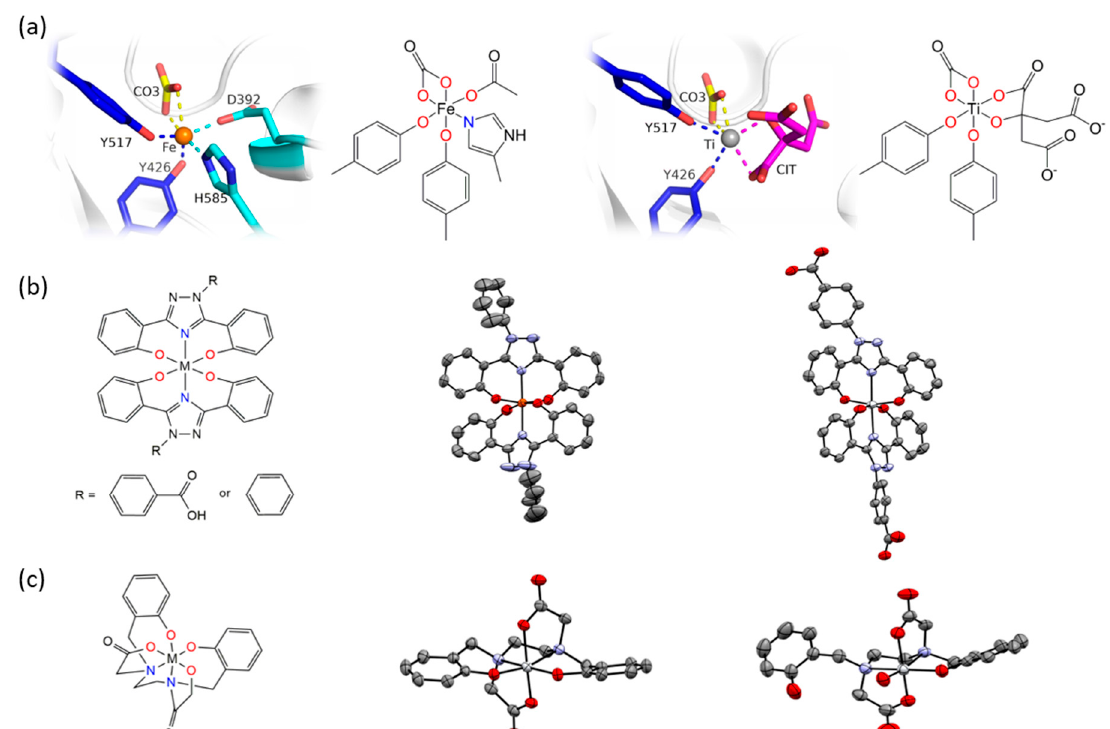
Figure 6. X-ray structures of Fe(III) and Ti(IV) coordination by serum transferrin (sTf) and by the small molecule chemical transferrin mimetic ligands. ( a ) The X-ray structures and chemical structures of the Fe(III) coordination modality (PDB 3QYT; left) and Ti(IV) coordination modality (PDB 5DYH; right) in the metal binding site of sTf. ( b ) The molecular representation (left) of the metal bisdeferasirox and metal bisdeferasirox analogue compounds demonstrating the meridional coordination of the ligands. The X-ray structure of [Fe(3,5-bis(2-hydroxylatephenyl)-1-phenyl-1,2,4-triazole) 2 ] − (middle; CCDC 237449). Ref. [55]. The cation was omitted for clarity. The X-ray structure of [Ti(Deferasirox) 2 ] (right; CCDC 2016873). Ref. [57]. The hydrogen atoms were omitted for clarity. ( c ) The molecular representation (left) of the metal HBED compounds in which HBED serves as a hexadentate ligand. The X-ray structure of Ti(HBED) in which HBED coordinates the metal in hexadentate modality (middle; CCDC 645069). Ref. [59]. The hydrogen atoms were omitted for clarity. This structure is comparable to the X-ray structure of [Fe(HBED)] − (CCDC 1194788; Ref. [60]). The X-ray structure of [TiO(H + -HBED)] − in which partial metal hydrolysis resulted in the HBED ligand coordinating the metal in pentadentate modality (right; CCDC 846178). The cation was omitted for clarity. Ref.